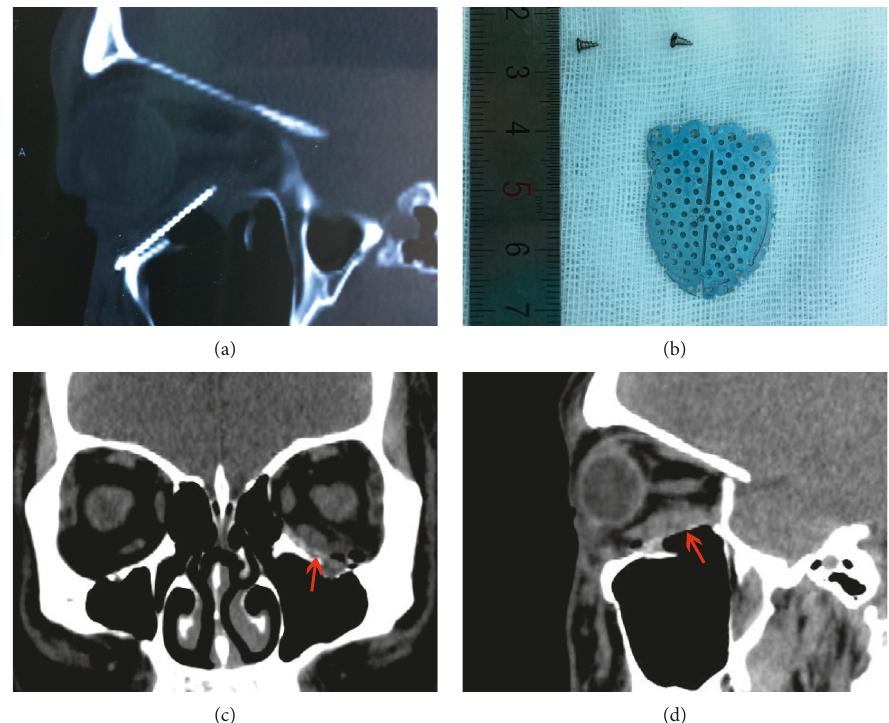
Figure 3: Case with severe ocular movement pain. (a) CT image showing the superiorly displaced floor implant and significantly in- carcerated extraocular muscle. (b) The removed titanium mesh and screws. (c and d) Coronal and sagittal CT views of the implanted RapidSorb at 10months postoperatively.